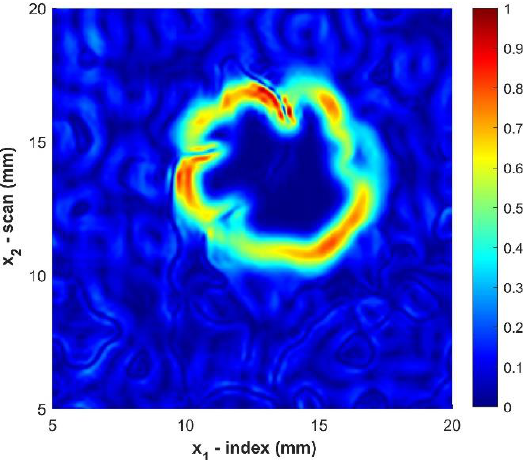
Figure 9. Magnitude of the gradient of the gated c-scan for sample B2. Color indicates the normalize amplitude of the magnitude of the gradient.